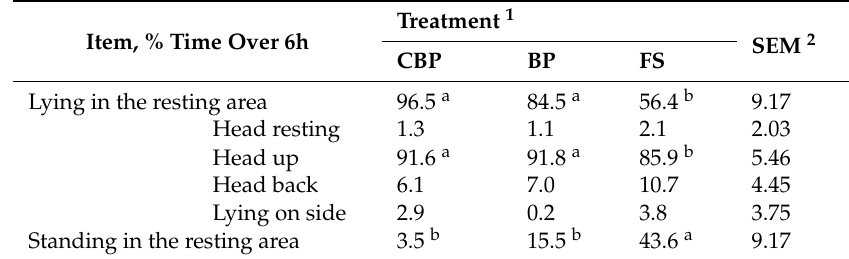
Table 7. E ff ects of the treatments (compost bedded pack barn, bedded pack barn and freestalls) on behavior patterns observed by scan sampling at 5-min intervals over two 3 h